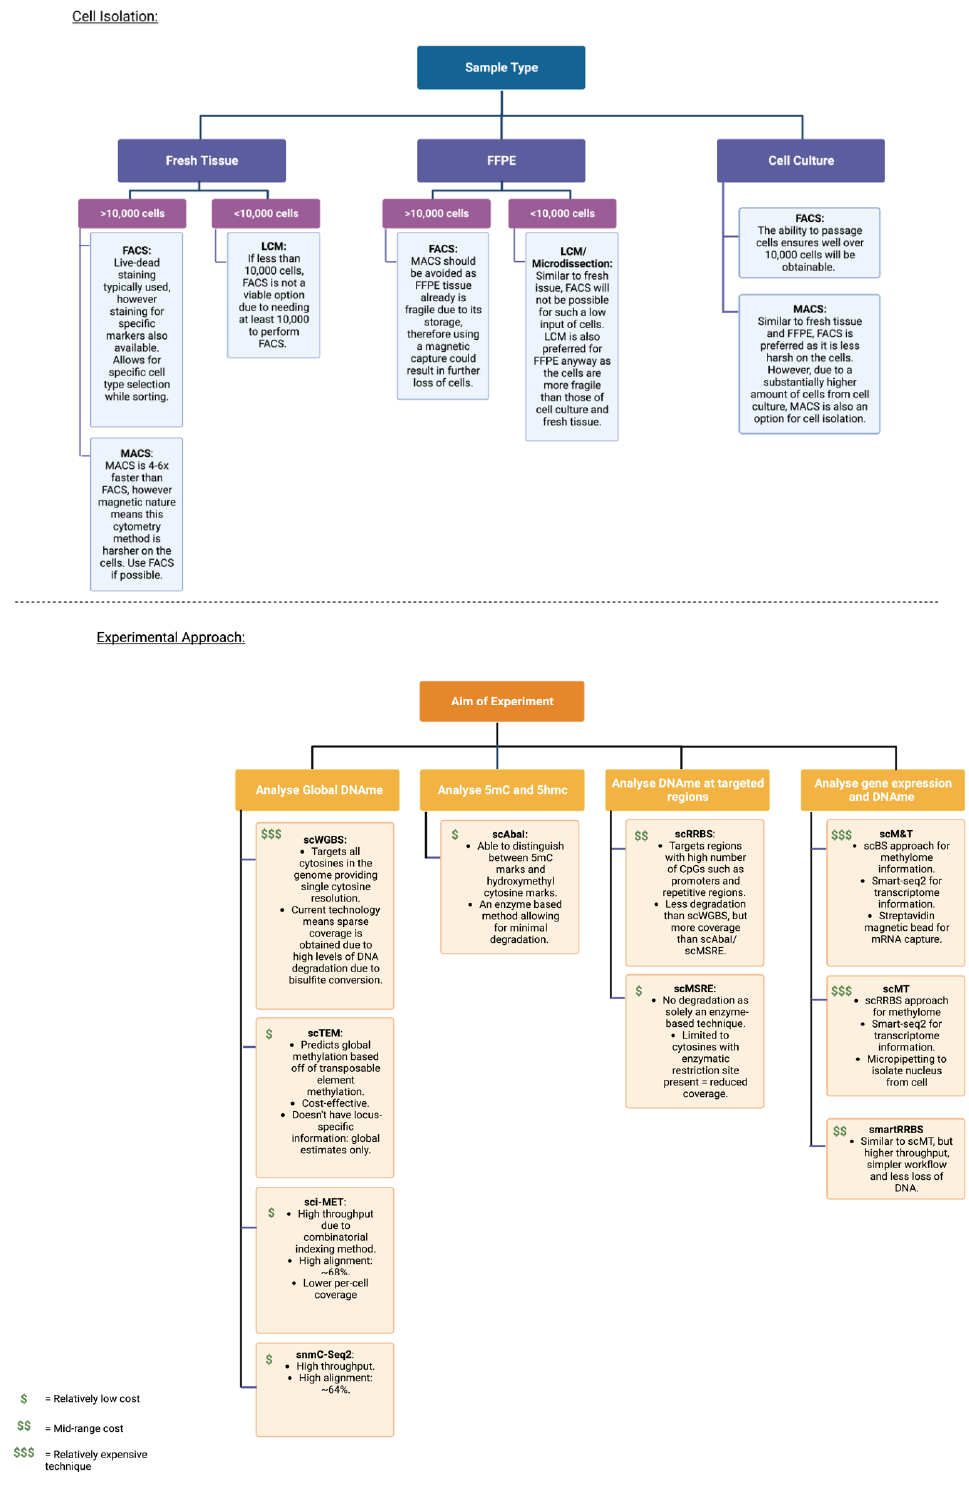
Figure 2. Single-cell isolation and experimental approaches for single-cell DNA methylation analyses. Created using https://biorender.com/ (accessed on 13 December 2022).